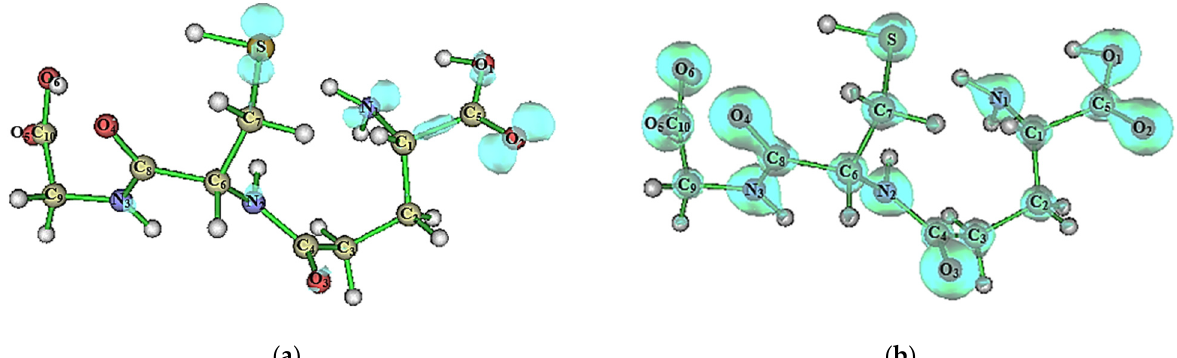
Figure 9. Isosurfaces of the ( a ) f 0 and ( b ) f − functions, calculated at a proper value of 0.5 for the glutathione molecule.